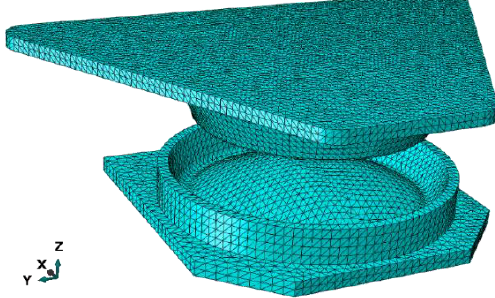
Figure 5. Numerical model of